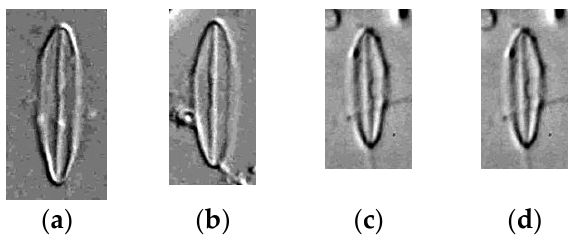
Figure 2. Berkeleya transfretana. LM. Individuals from the type population (valve views).